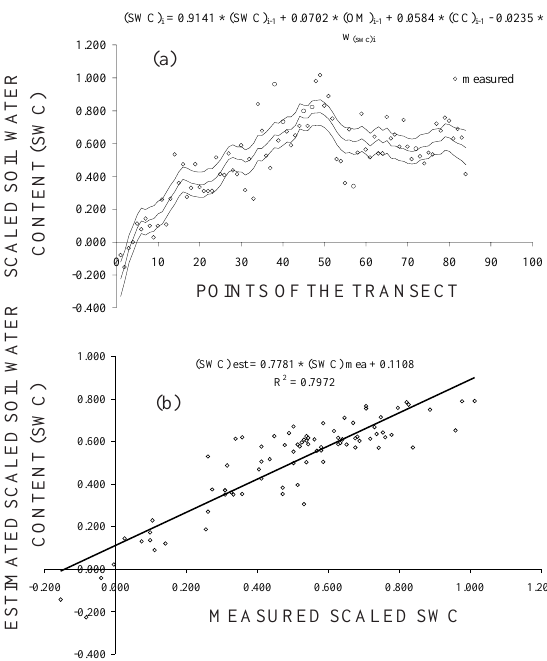
Figure 4. State-space analysis of scaled soil water content data as a function of scaled soil water content, scaled soil organic matter, scaled clay content and scaled aggregate stability at location i-1 (a); correlation between estimated and measured scaled soil water content data of (a)